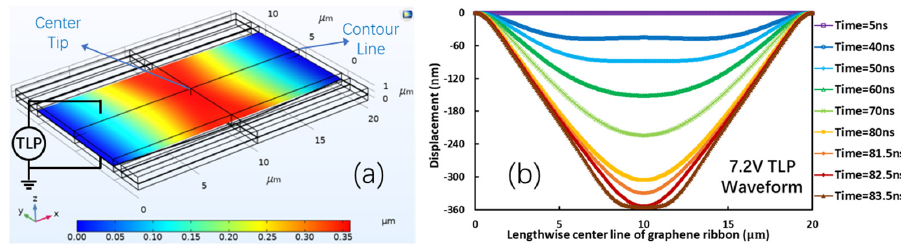
Figure 6. ( a ) The 3D transient FEM simulation shows vertical displacement of the graphene ribbon in a gNEMS of L = 20µm, W = 10µm, and d = 350 nm at the moment of contact. Physical displacement in Z -axis is color-coded with blue for zero displacement at z = 0 and red for the largest bending of z = − 350 nm at the moment of contact; ( b ) simulated graphene ribbon’s vertical displacement resulting from the stress induced by a 7.2 V TLP pulse for a sample gNEMS reveals the t-dependence of the triggering behaviors of gNEMS.